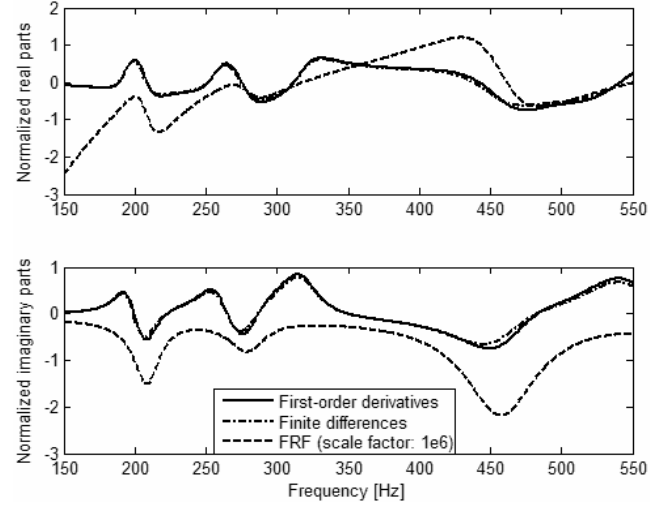
Fig. 5. Sensitivities of the FRF H II ( ω,T,p ) with respect to the thickness of the viscoelastic